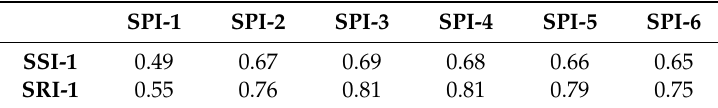
Table 5. Spearman correlation coe ffi cients between SPI at 1- to 6-month timescales and SSI and SRI at the 1-month